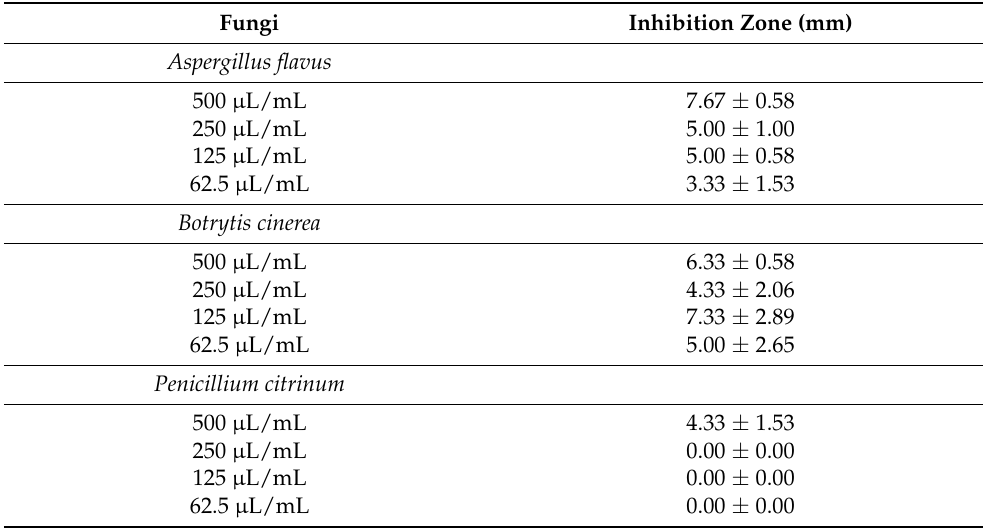
Table 5. Minimal inhibition concentration of microscopic